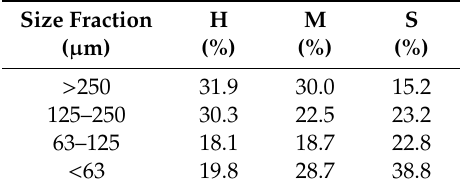
Table 4. Mass recovery of the different size fractions of the samples H, M and S.